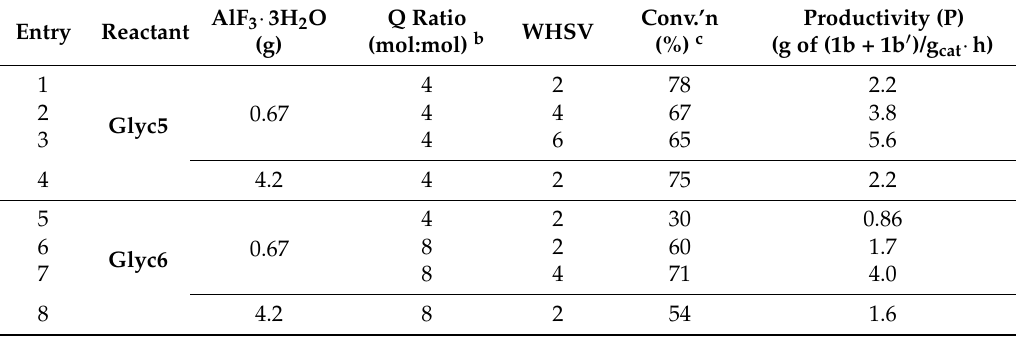
Table 2. Comparison of acetalization of Glyc5 and Glyc6 with acetone catalyzed by AlF 3 ¨ 3H 2 O a